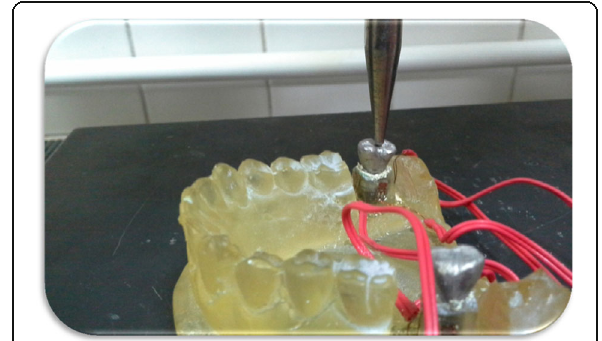
Fig. 5 Loading of implant axially